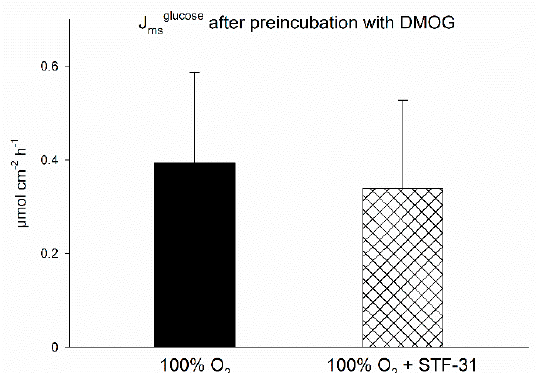
Figure 3. J msglucose across isolated lagomorph jejunum epithelia after preincubation with DMOG and with or without the GLUT1-inhibitor STF-31. Epithelia were incubated as described above but preincubated with 2 mM DMOG instead of simulating hypoxia. J msglucose was not significantly different between epithelia preincubated with DMOG only and epithelia incubated with DMOG and STF-31 (inhibiting GLUT1). There is no significant difference between the groups. Bars represent mean ± SD; N = 6 ( n = 12) for DMOG only and N = 4 ( n = 8) for DMOG + STF-31.